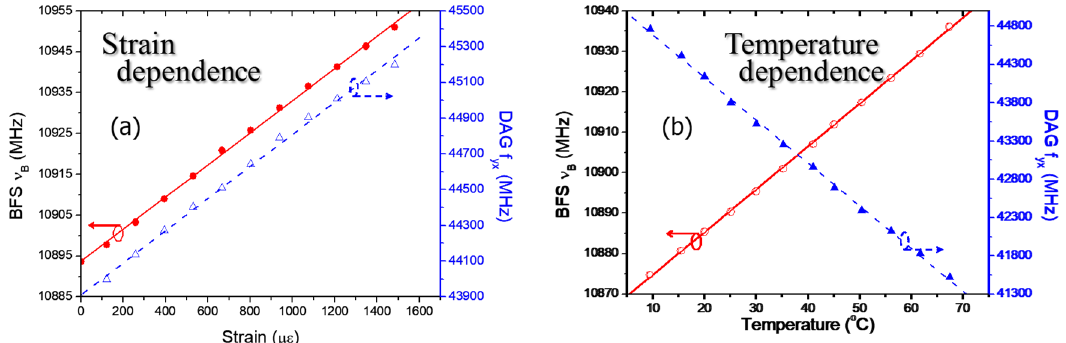
Figure 41. Strain and temperature dependence of the BFS and the BDG Bragg reflection frequency in polarization-maintaining optical fiber [106]. Strain dependence ( a ) and temperature dependence ( b ) of a polarization-maintaining optical fiber [106]. Strain dependence (a) and temperature dependence (b) of the BFS and the BDG Bragg reflection frequency.